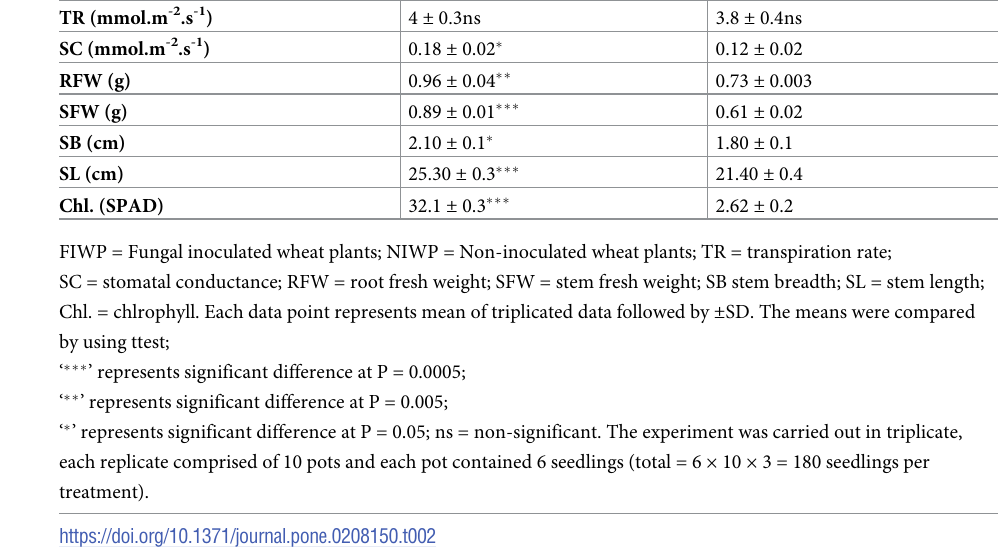
Table 2. Growth parameters of fungal inoculated and non-inoculated wheat plants under heavy metal stress.